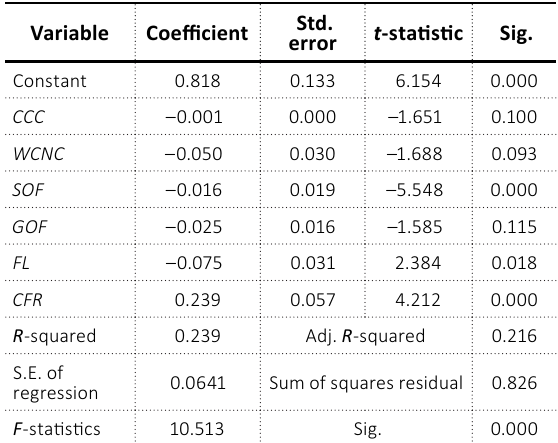
Table 7. Determinants of cash holding (CH)